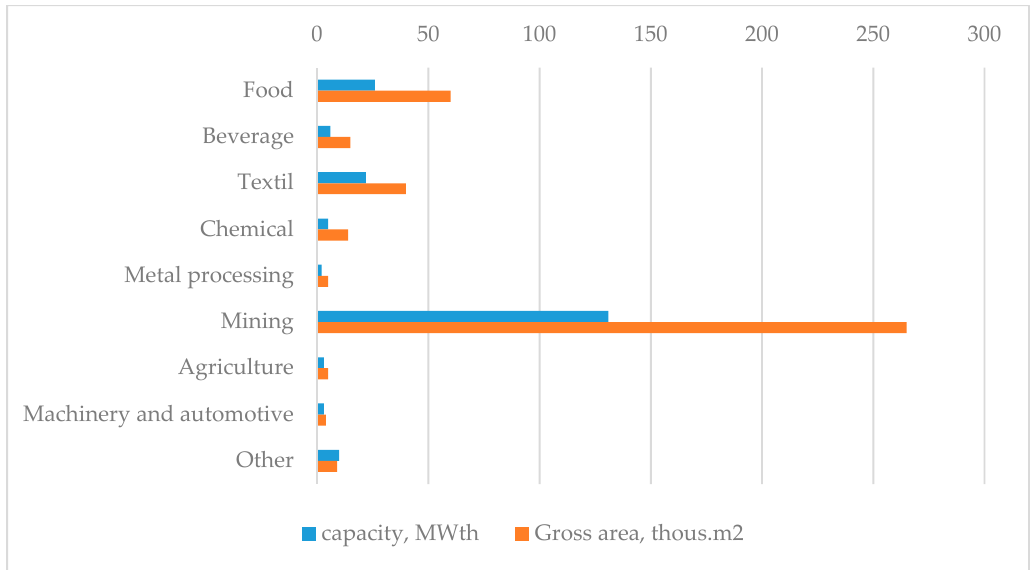
Figure 6. Distribution of industrial solar installations (capacity, gross area) by application [23].